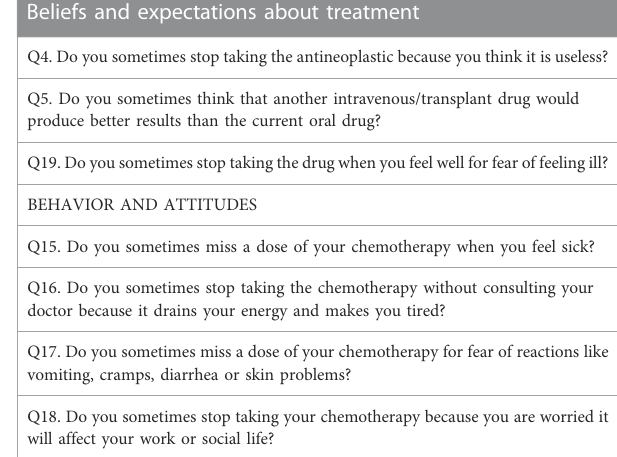
TABLE 4 EXPAD-ANEO scale. Beliefs and expectations about